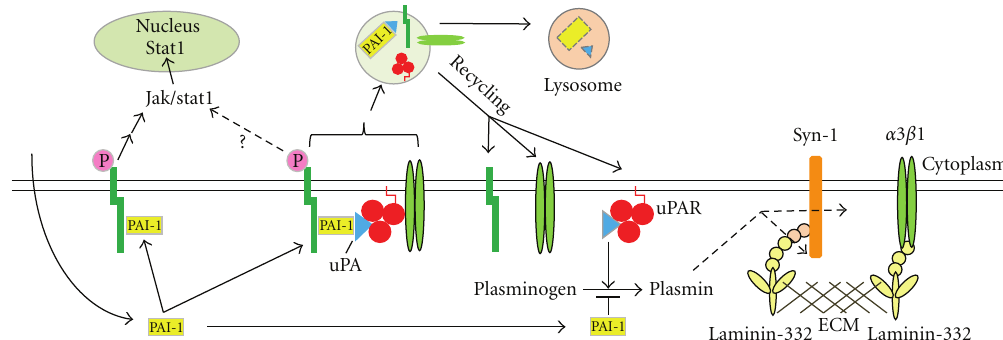
Figure 4: PAI-1 modulates migration through cell surface receptors. PAI-1 binding to LRP1, in a non-uPA/uPAR-dependent manner, triggers Jak/Stat1 signaling events that culminate in enhanced cell migration (left). It is unclear whether this process requires PAI-1 interaction with the ECM. PAI-1 binding to uPA/uPAR results in the internalization of the PAI-1/uPA/uPAR complexes in an LRP1-dependent manner (middle). PAI-1 binding to uPA/uPAR can also trigger the detachment of cell surface integrins from their ECM ligands and subsequent internalization in an LRP1-uPA/uPAR-dependent manner. In each case, receptors (integrin, uPAR, LRP1) recycled back to the cell surface, while uPA and PAI-1 are degraded. PAI-1, through its ability to titer active plasmin, may also promote syndecan-1-dependent migration on unprocessed laminin-332 by preventing the cleavage of the syndecan-binding site LG4/5 (right). Additionally, inhibition of plasmin activation by PAI-1 facilitates migration on unprocessed laminin-332 by reducing the shedding of syndecan-1 from the cell surface. As the proteolytic environment matures and PAI-1 levels decrease, integrins α 3 β 1 and α 6 β 4 (not shown) engage the proteolytically-cleaved or processed form of laminin-332 facilitating construction of hemidesmosomes.